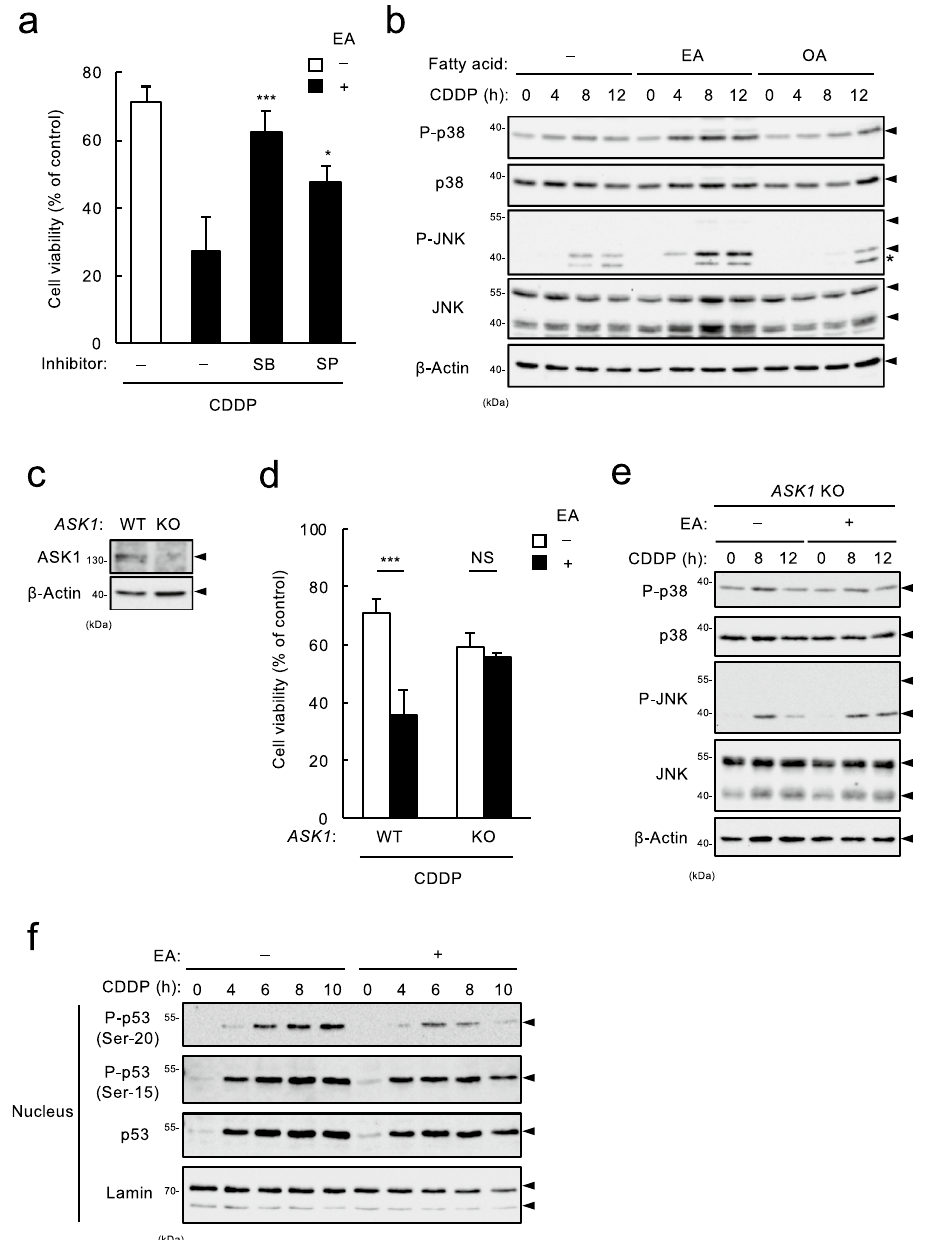
Figure 3. Pro-apoptotic action of EA depends on hyperactivation of the ASK1-p38/JNK MAP kinase pathway. ( a ) U2OS cells were pretreated with 200 μM EA for 11.5 h, treated with either p38 inhibitor SB203580 (SB, 5 μM) or JNK inhibitor SP600125 (SP, 5 μM) for 0.5 h, and then stimulated with 40 μM CDDP for 24 h, subjected to cell viability assay. Data shown are the mean ± SD (n = 3). * p < 0.05; *** p < 0.001 (vs. cells pre- treated with EA in the absence of any inhibitor). ( b ) U2OS cells were pretreated with 200 µM EA or OA for 12 h, and then stimulated with 40 μM CDDP for the indicated time periods. Cell lysates were subjected to immunoblotting with the indicated antibodies. *, non-specific band. ( c ) ASK1 WT and KO U2OS cells were lysed and subjected to immunoblotting with the antibodies against ASK1 and β-actin. ( d ) ASK1 WT and KO U2OS cells were pretreated with or without 200 μM EA for 12 h, and then treated with 40 μM CDDP for 24 h, subjected to cell viability assay. Data shown are the mean ± SD (n = 3). ( e ) ASK1 WT and KO U2OS cells were pretreated with or without 200 µM EA for 12 h, and then stimulated with 40 μM CDDP for 0, 8 and 12 h. Cell lysates were subjected to immunoblotting with the indicated antibodies. ( f ) U2OS cells were pretreated with or without 200 µM EA for 12 h, and then stimulated with 40 μM CDDP for the indicated time periods. Nuclear extracts obtained from the cell lysates were subjected to immunoblotting with the indicated